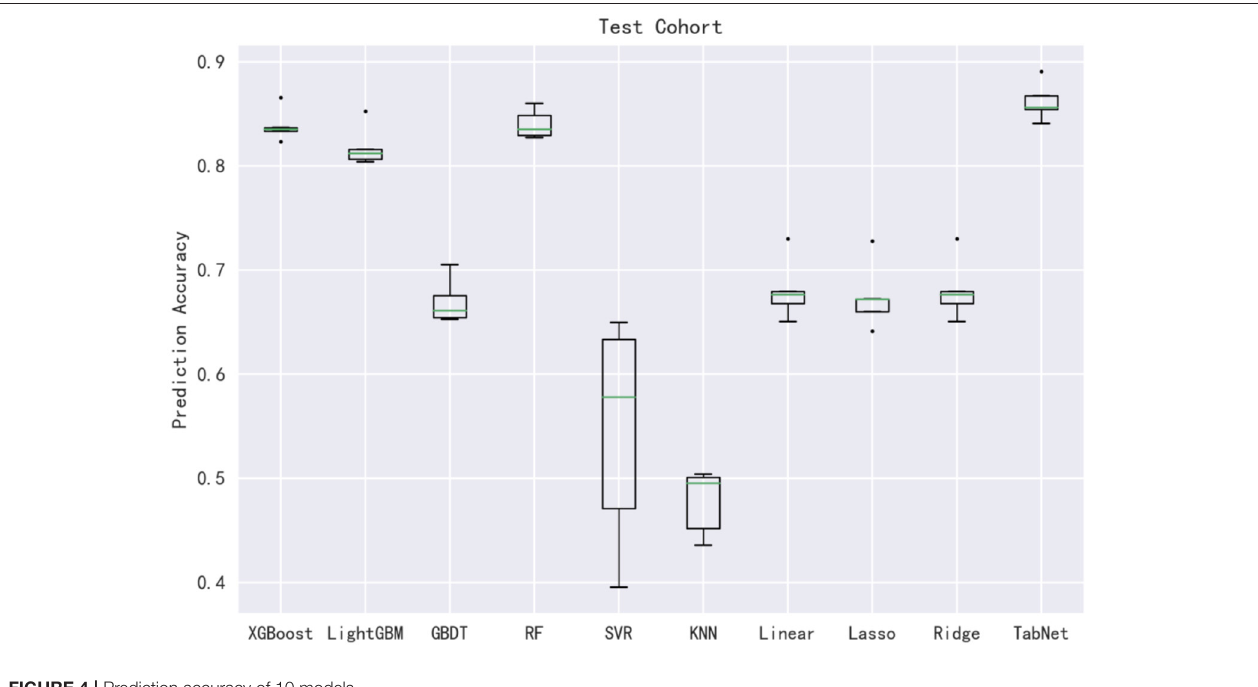
FIGURE 4 | Prediction accuracy of 10 models.